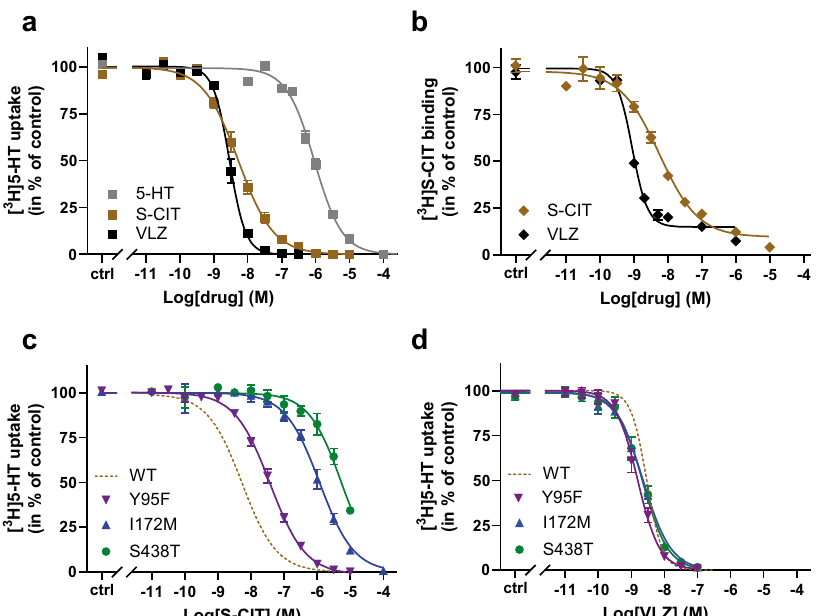
Fig. 1 Characterization of VLZ binding to SERT WT and S1 mutants. a Inhibition potency of VLZ (black) and S-CIT (brown) compared to 5-HT (gray). The af fi nity for VLZ is 5-fold higher than for S-CIT in inhibiting [ 3 H]5-HT transport with K i values of 1.06 [0.90; 1.25] and 5.21 [4.19; 6.48] nM, respectively ( n = 6). b Equilibrium binding inhibition for S-CIT and VLZ displacement of [ 3 H]S-CIT. The K i for VLZ is 7-fold higher than for S-CIT (0.68 [0.56; 0.83] and 5.13 [2.85; 3.76] nM, respectively). c , d The af fi nity for S-CIT but not VLZ is affected by mutations in the SERT S1 site. S-CIT binding is decreased by 7- and 192- and 625-fold by the mutations Y95F (purple), I172M (blue) and S438T (green), respectively relative to WT (dotted line of data in a ). The mutations do not signi fi cantly affect the af fi nity for VLZ. V MAX , K M , K i , and n -values for 5-HT, S-CIT, and VLZ binding to SERT WT and S1 mutants are shown in the Supplementary Table 1. Experiments are performed in triplicates on intact COS7 cells transiently expressing SERT WT or mutants. Data are shown as means ± S.E. (error bars), n = 4 – 17. Source data are provided as a Source Data fi